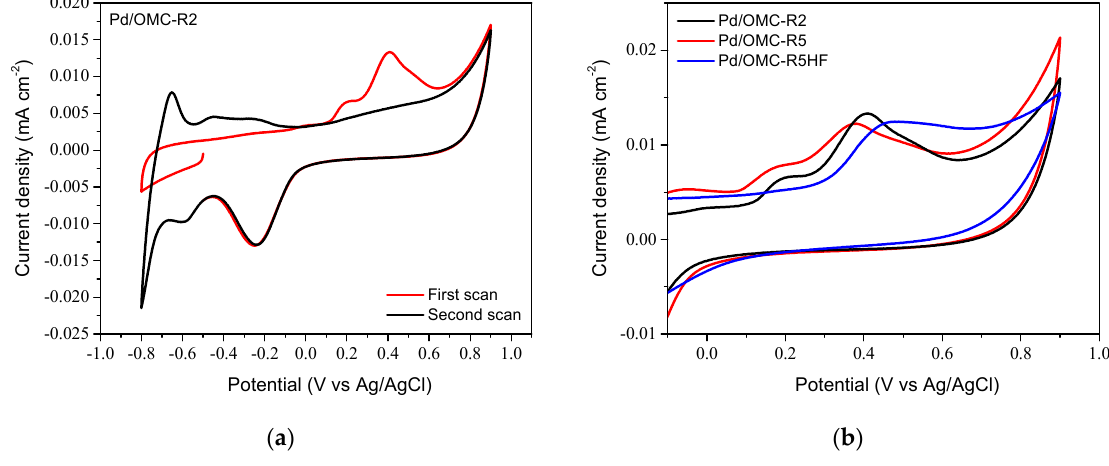
Figure 6. CO stripping voltammograms of Pd/OMC catalysts in 0.1 M KHCO 3 ( v = 10 mV s − 1 , E ad = - 0.5 V vs. Ag/AgCl): ( a ) Pd/OMC-R2; ( b ) Comparison of the first scan of Pd/OMC catalysts.